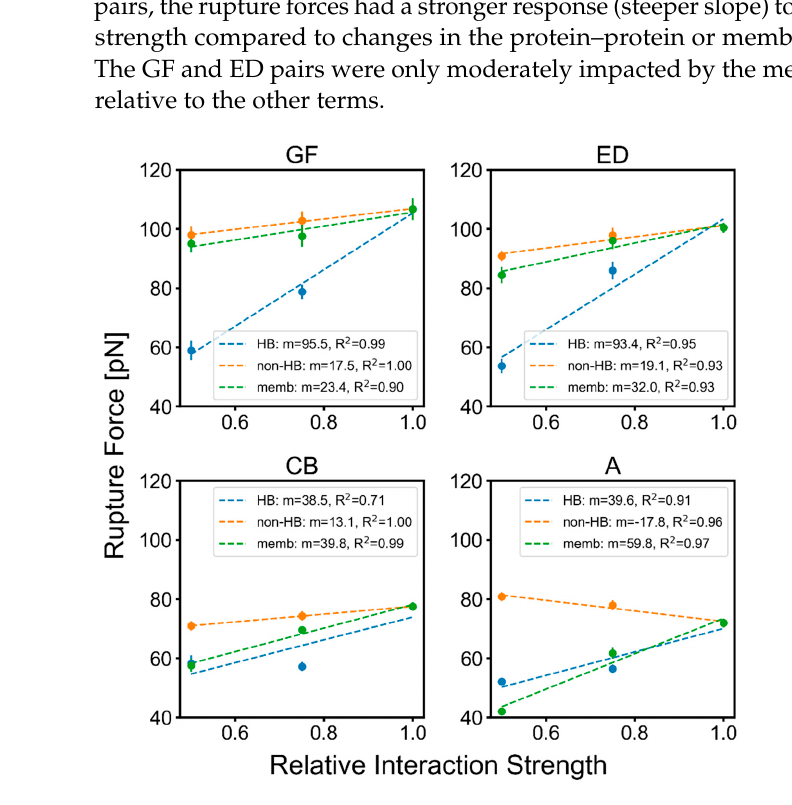
Figure 3. bR helix rupture force trends when scaling different interaction terms. The rupture forces are averages from 28 replicas. HB: H-bonding; non-HB: other protein–protein interactions; memb: membrane potential. The m values are the slope (unit: pN/relative interaction strength).